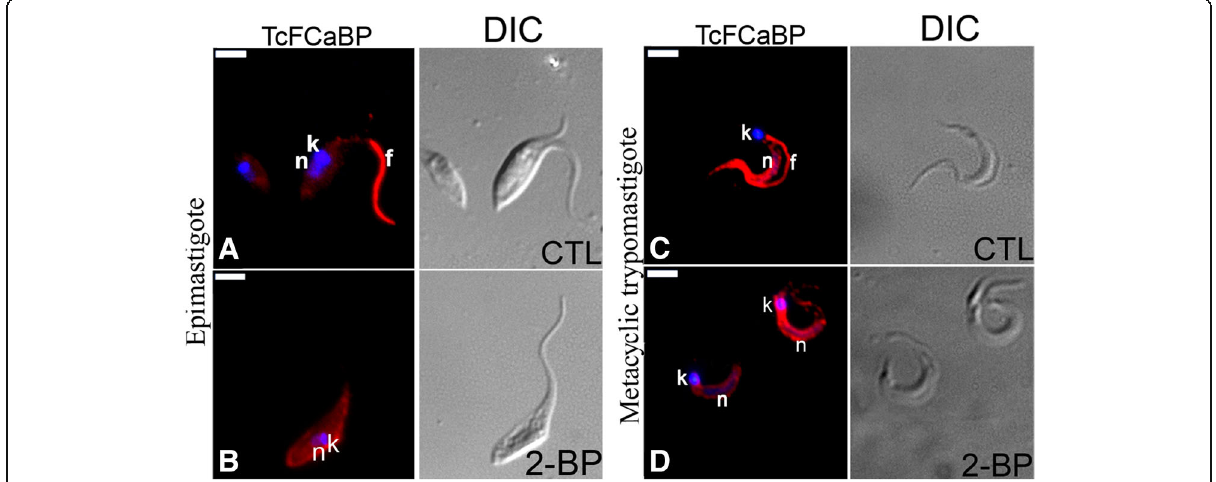
Fig. 2 Localization of TcFCaBP in Trypanosoma cruzi epimastigotes and metacyclic trypomastigotes after 2-BP treatment. a - c Negative control (CTL), showing flagellar localization (in red) of TcFCaBP in epimastigotes ( a ) and trypomastigotes ( c ). Nucleus and kinetoplast are stained with DAPI (blue). b - d Incubation with 130 μ M 2-BP hindered flagellar localization of TcFCaBP. n: nucleus; k: kinetoplast; f: flagellum. Bars = 5 μ